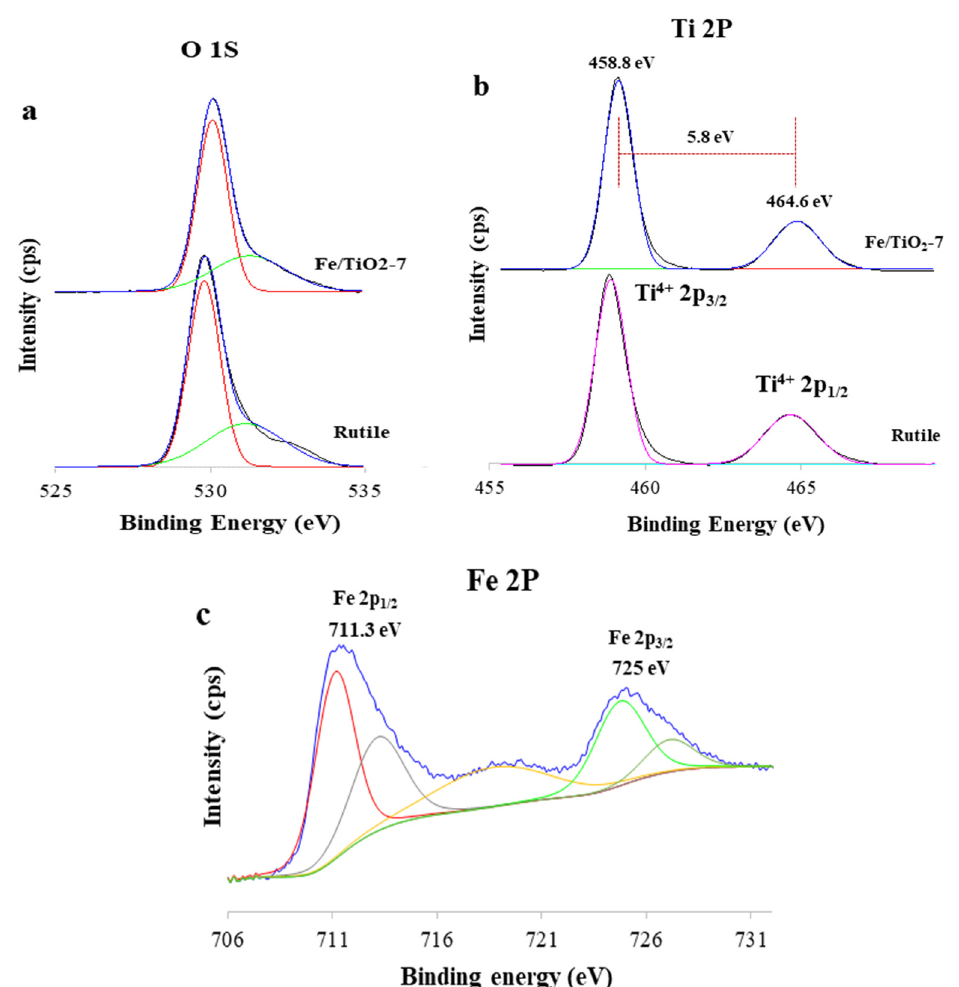
Figure 9. Deconvolution and XPS spectra curve fitting for the ( a ) O 1 s, ( b ) Ti 2p, and ( c ) Fe 2p of TiO 2 and Fe/TiO 2 –7.